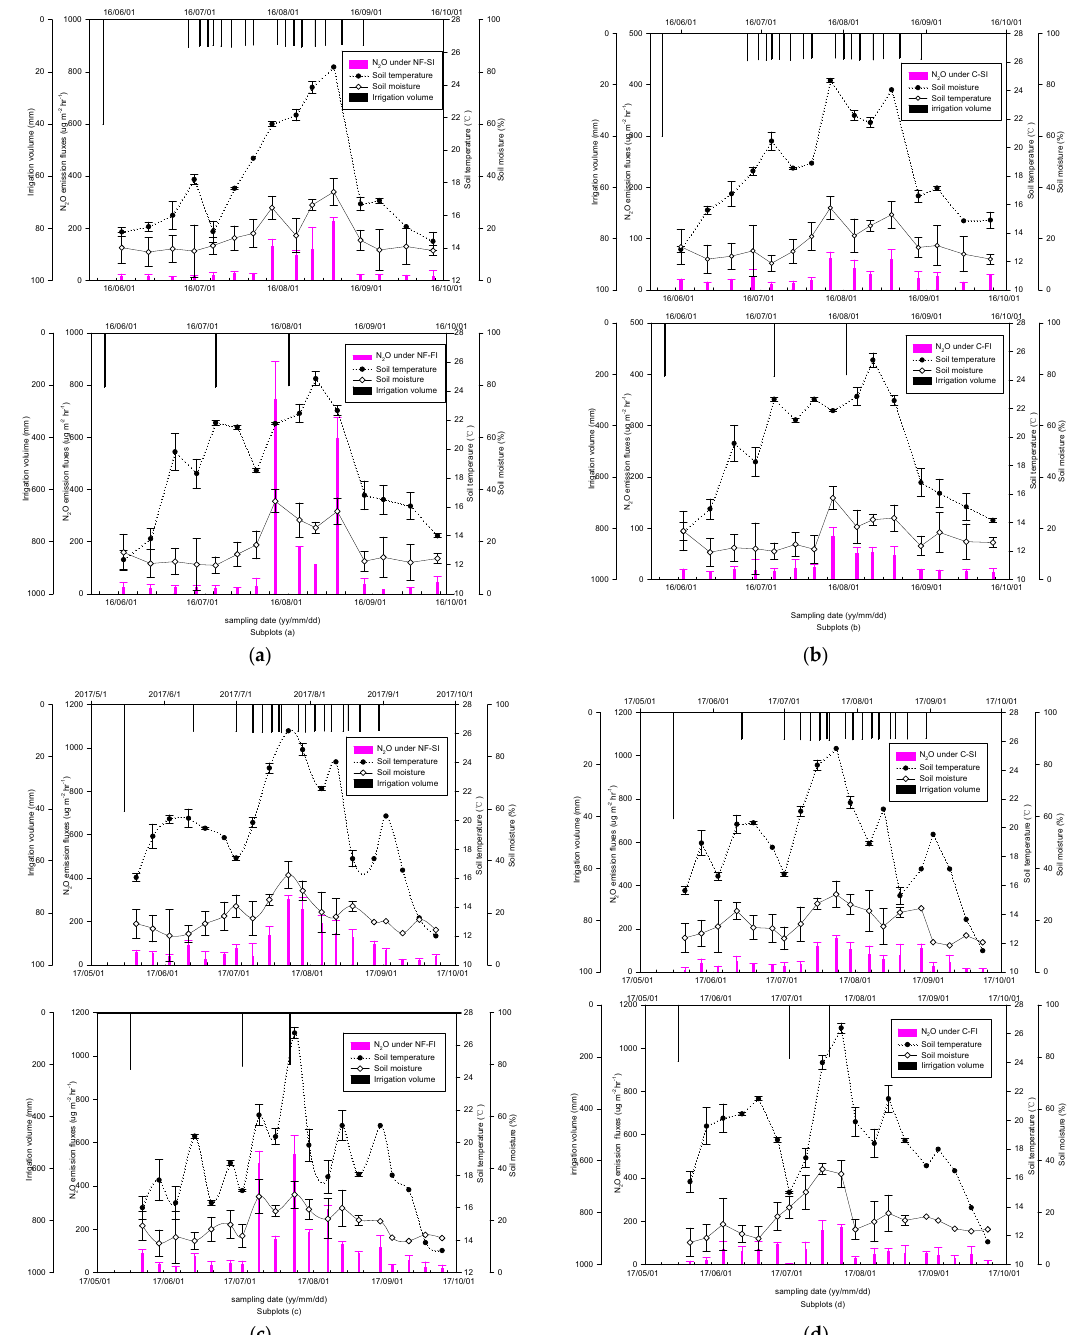
Table 3. Basic physical and chemical properties of soil under the two irrigation systems and for different fertilization treatments in 2016 and 2017.